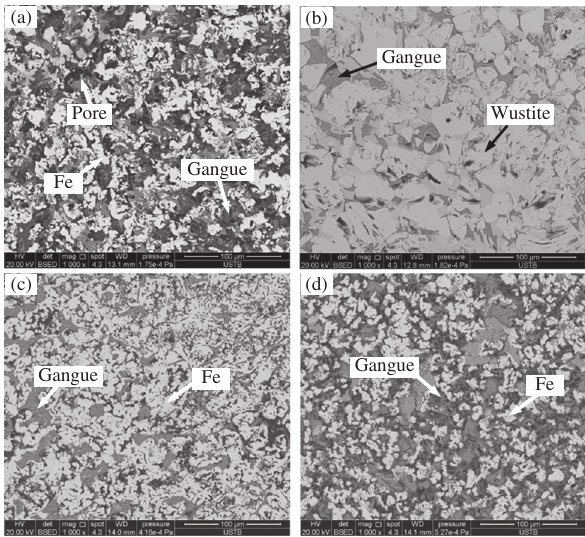
Figure 4: Microstructure of sinter in general condition [(a) edge; (b) center] and high reduction potential condition [(a) edge; (b)